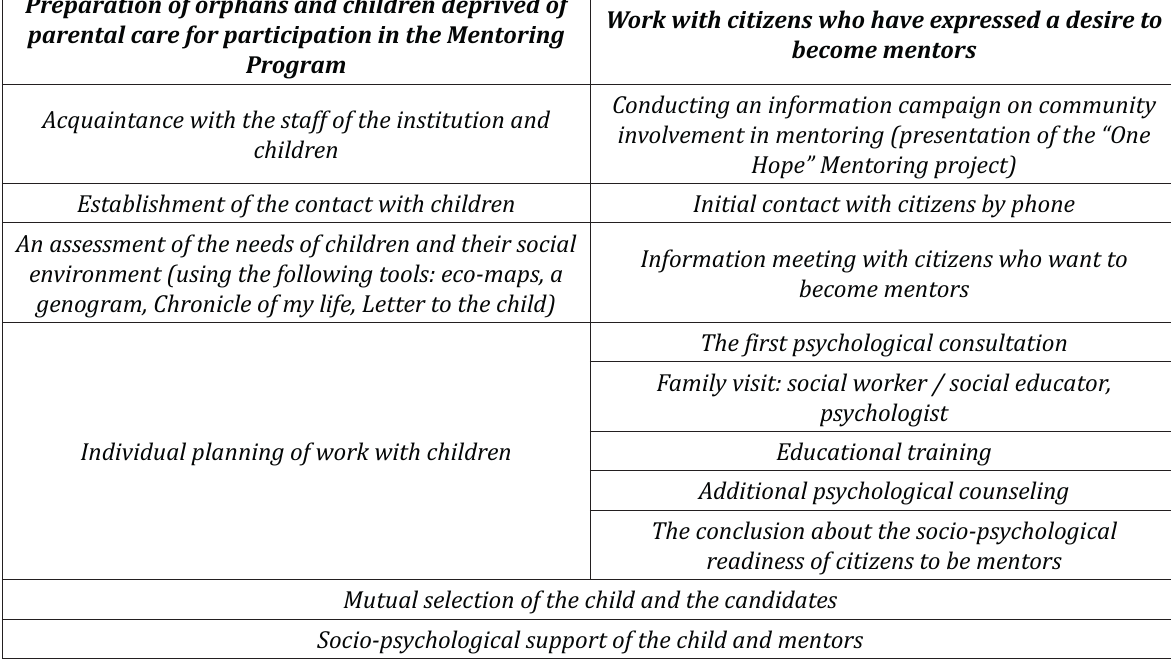
Table 1. The methodology of socio-psychological work in preparation for Preparation of orphans and children deprived of